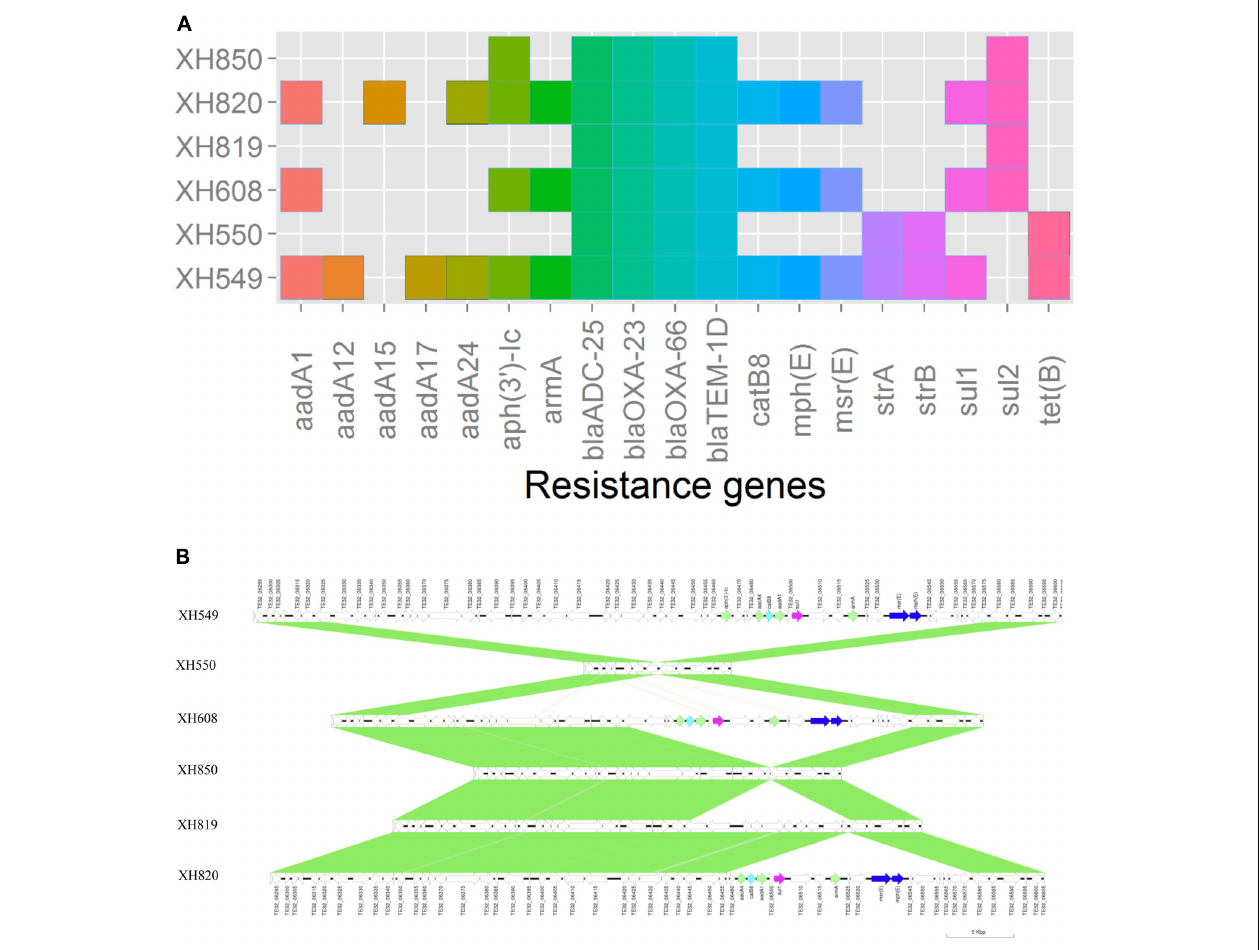
FIGURE 4 | Gene acquire and loss in three isolates pairs of A. baumannii . (A) Heatmap of resistance genes in three isolates pairs. Both XH549 and XH608 represent resistance gene loss. XH819 was shown to acquire resistance genes. (B) Comparative analysis of the genomes of three isolates pairs generated by Easyfig. The arrows for resistance genes are shown in different